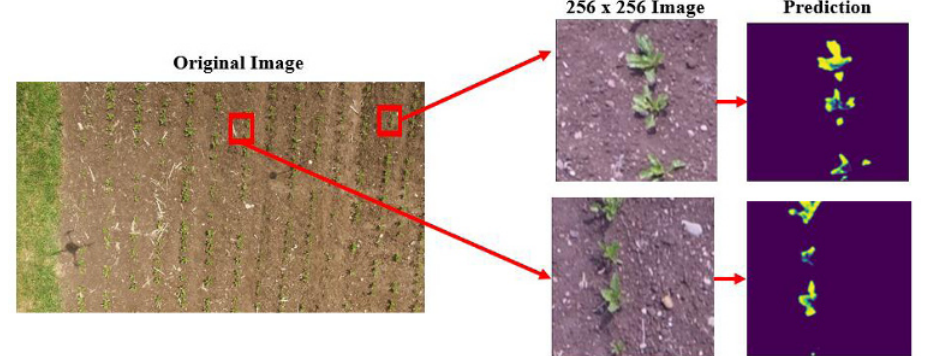
Fig. 6. Example of patch prediction using the trained model.